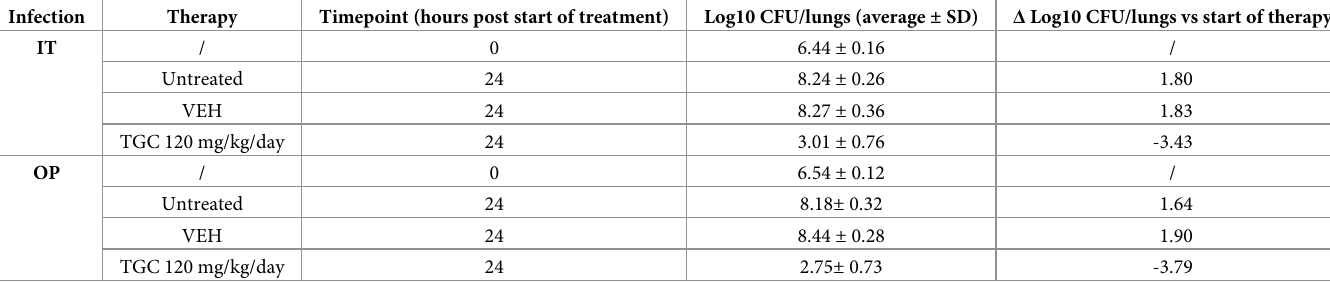
Table 5. Bacterial load in lungs of A . baumannii ACC001 infected mice treated with vehicle and tigecycline.